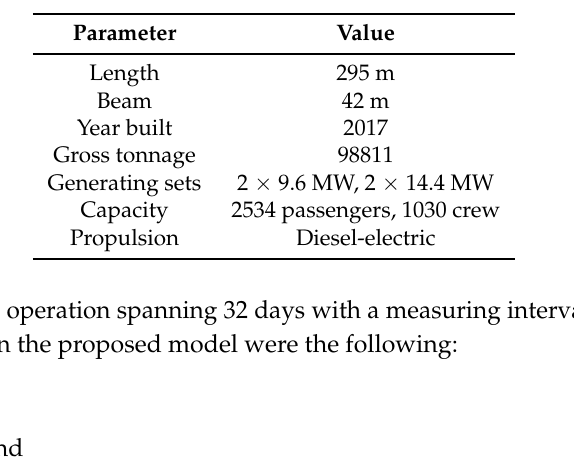
Table 1. Ship main parameters.